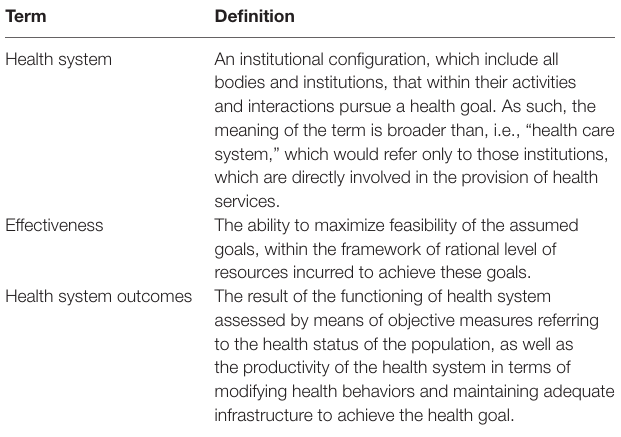
tAble 1 | Basic terminology relevant in context of the presented methodological